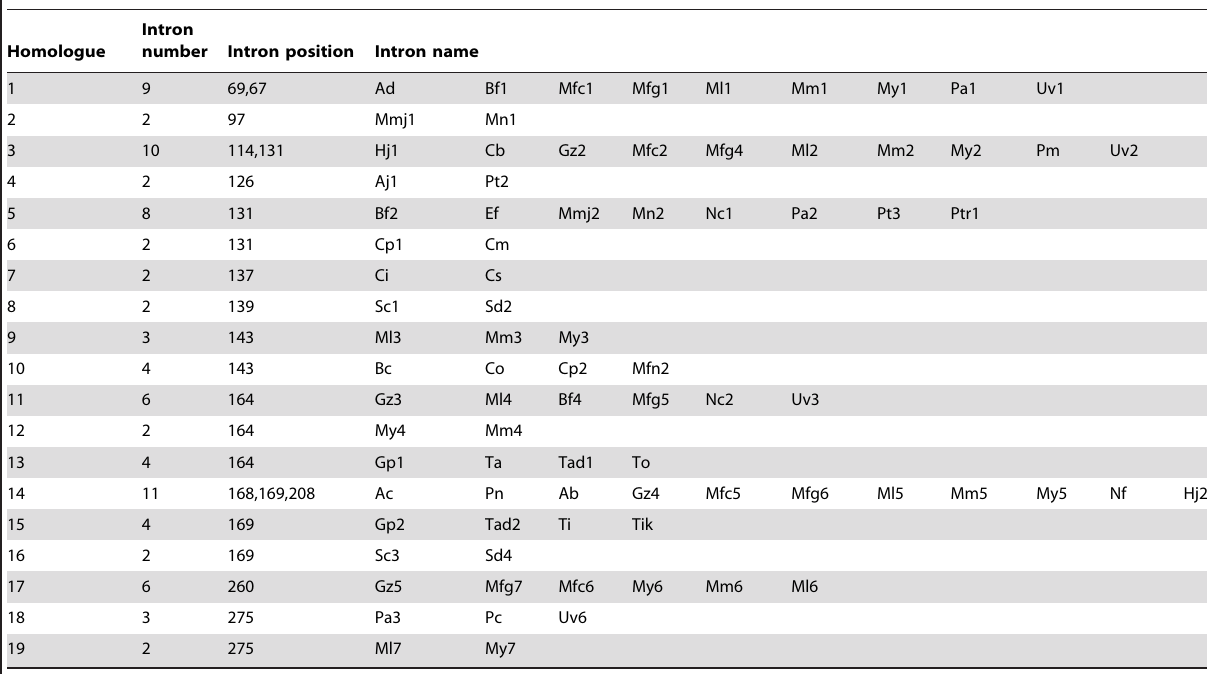
Table 3. Identification of homologues among fungal Cyt b gene introns 1 .